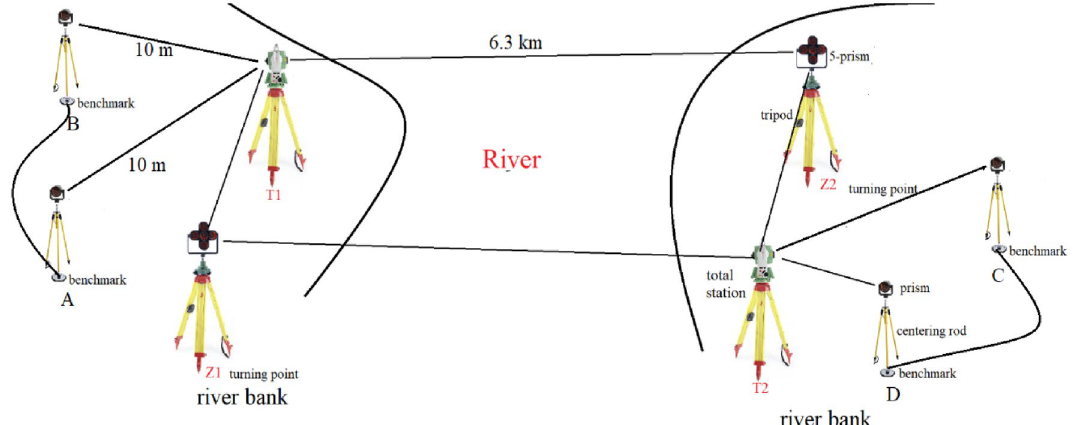
Figure 11. Observation route of Fuzhou Bridge in China. Leica TM50 I total station and GPR1 circle prism are used and the observation in conducted in the evening.